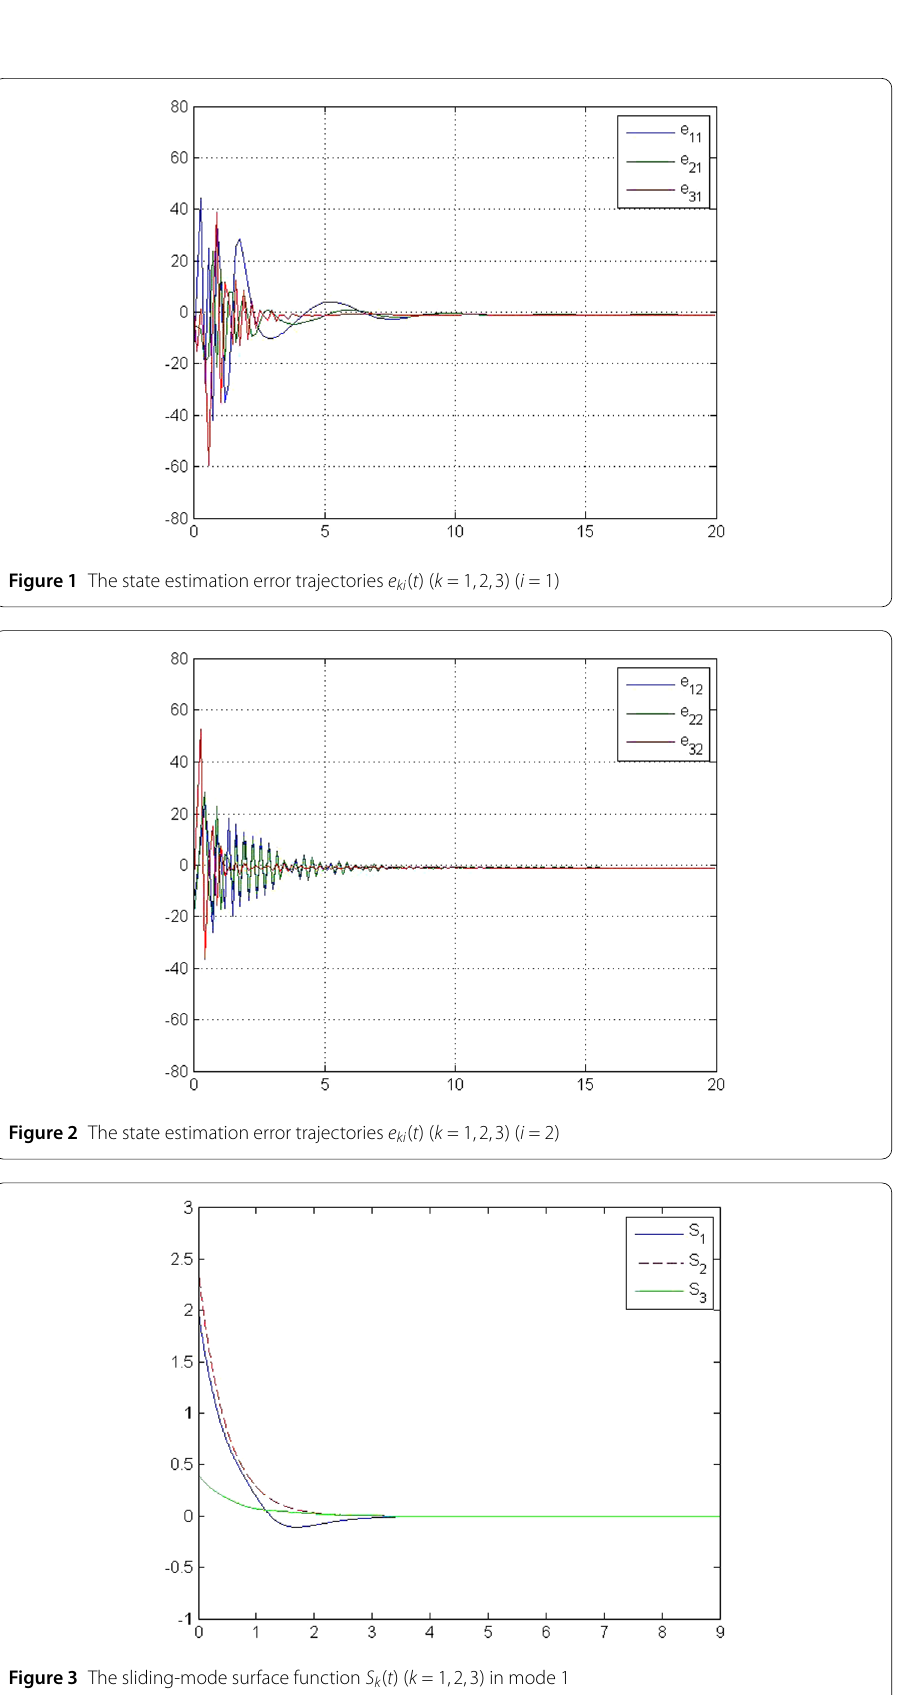
Figure 3 The sliding-mode surface function S k ( t ) ( k = 1,2,3) in mode